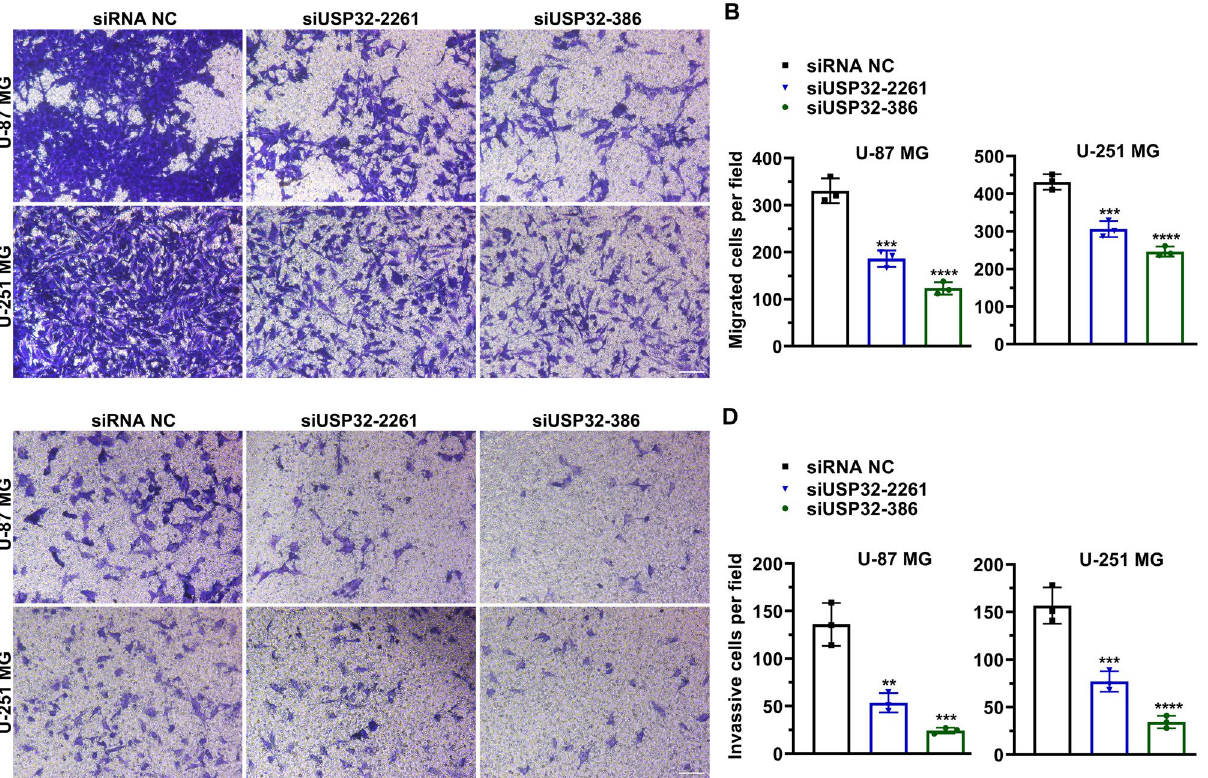
Figure 4. Knockdown of USP32 inhibits cell metastasis. ( A ) Transwell migration assay showing that silencing USP32 suppressed cell migration. Bar: 10 μm. Images were representatives of three independent experiments. ( B ) Statistical quantification of ( A ). ( C ) Matrigel invasion assay showing that USP32 deficiency suppressed cell invasion. Bar: 10 μm. Images were representatives of three independent experiments. ( D ) Statistical quantification of ( C ). One way ANOVA followed by Tukey’s post-hoc test: vs siRNA NC, ** p < 0.01, *** p < 0.001, **** p <